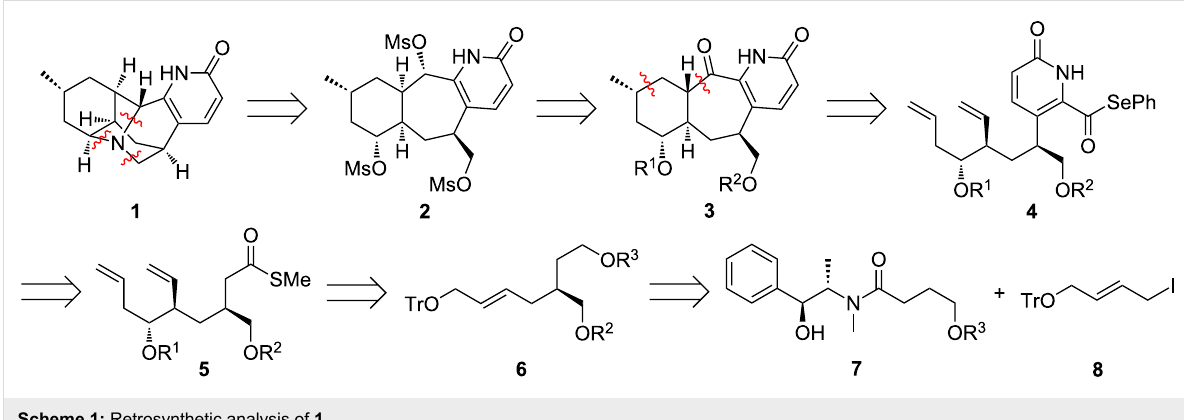
Scheme 1: Retrosynthetic analysis of 1